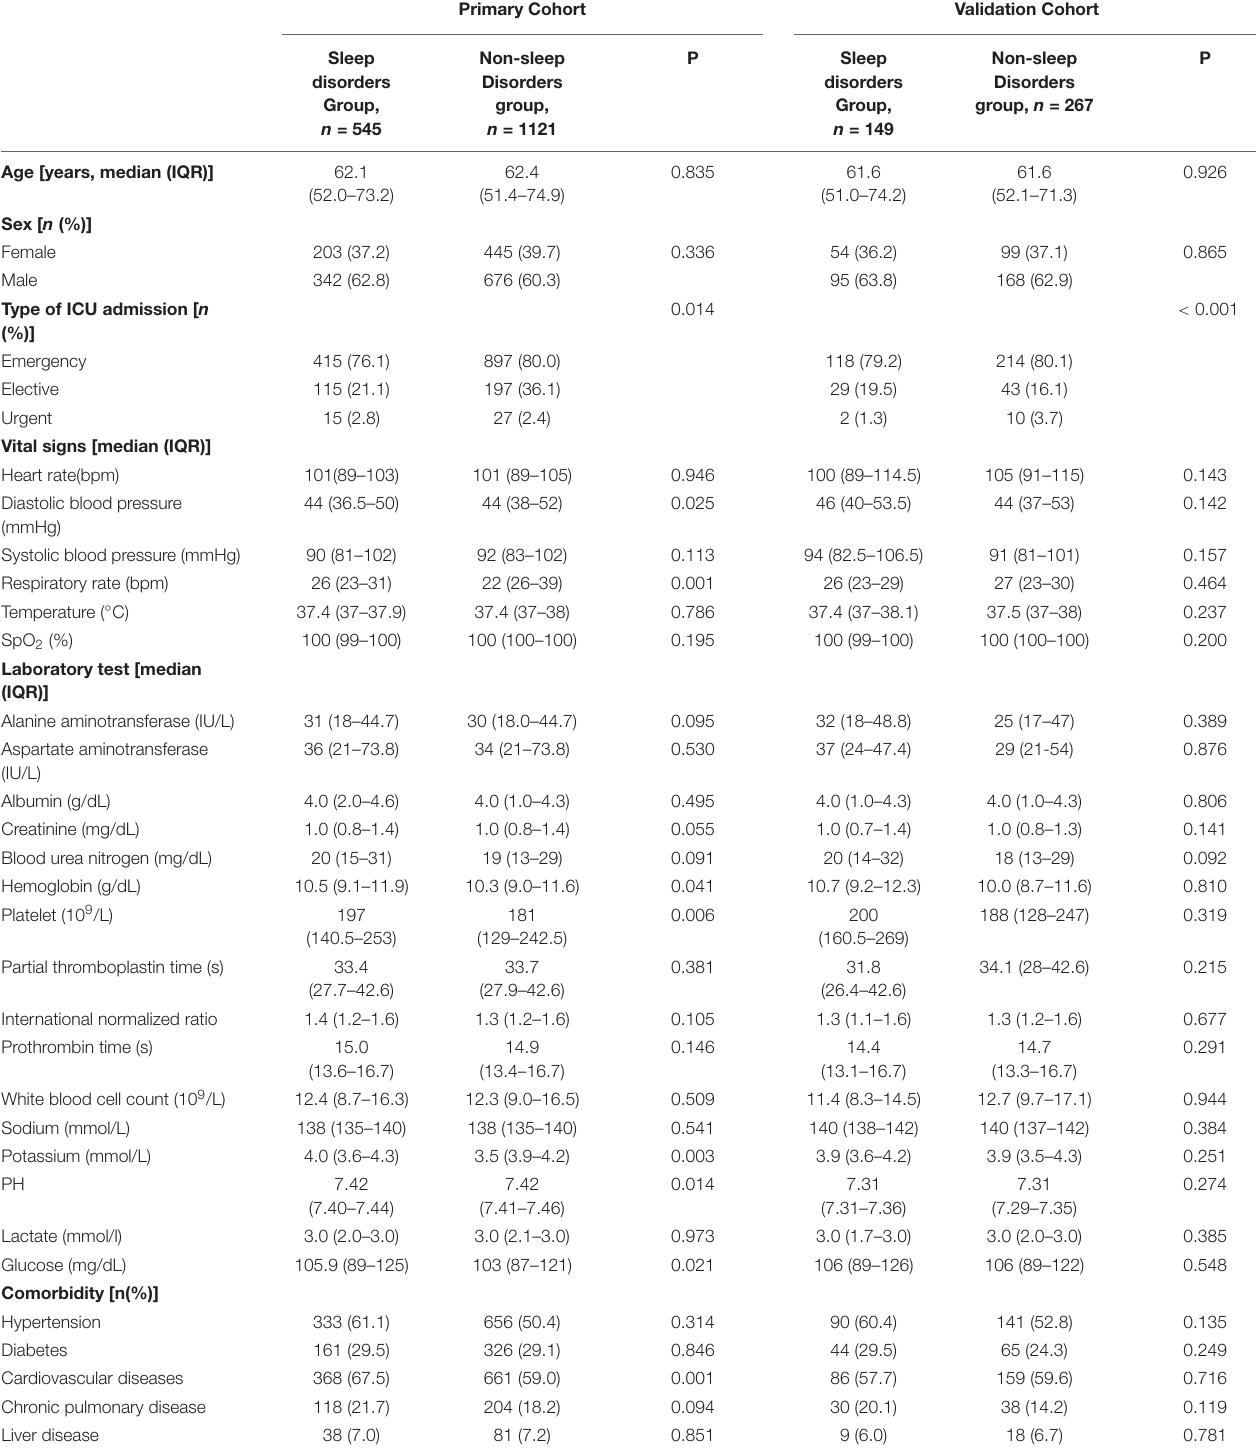
TABLE 1 | Characteristics of patients in the training and validation